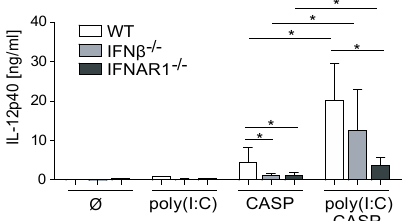
Figure 3. Differential effects of poly(I:C) pre-treatment on cytokine production during CASP. WT, Figure 3. Di ff erential e ff ects of poly(I:C) pre-treatment on cytokine production during CASP. WT, IFN β − / − and IFNAR1 − / − mice were pre-treated with 200 µ g poly(I:C) followed by CASP surgery. IL-12p40 concentrations in the serum were determined by ELISA. n = 5–7 animals per group. Error bars indicate SD. * p < 0.05 using Student’s t